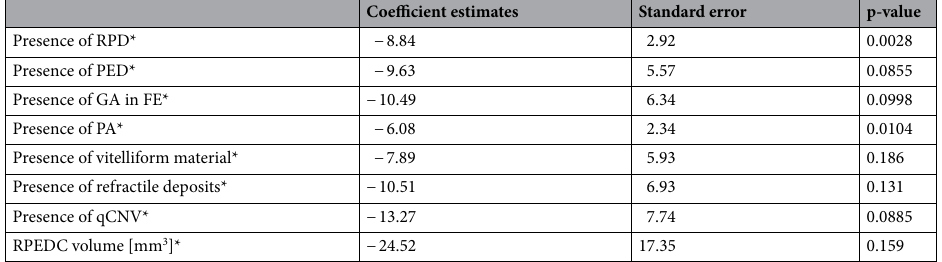
Table 3. Results of separate linear mixed-model analyses of the impact of iAMD high-risk features on the rEZR in eyes with iAMD as presented with coefficient estimates, standard error and p-value, respectively. *Each separate linear mixed-model was adjusted for patient’s age, gender and the eccentricity. iAMD intermediate age-related macular degeneration, RPD reticular pseudodrusen, PED pigment-epithelium detachment, GA geographic atrophy, FE fellow eye, PA pigmentary abnormalities, qCNV quiescent choroidal neovascularization, RPEDC retinal-pigment-epithelium complex volume.